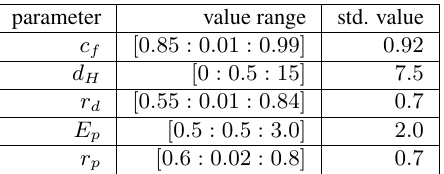
Table 2: Overview of studied parameters, value ranges (given